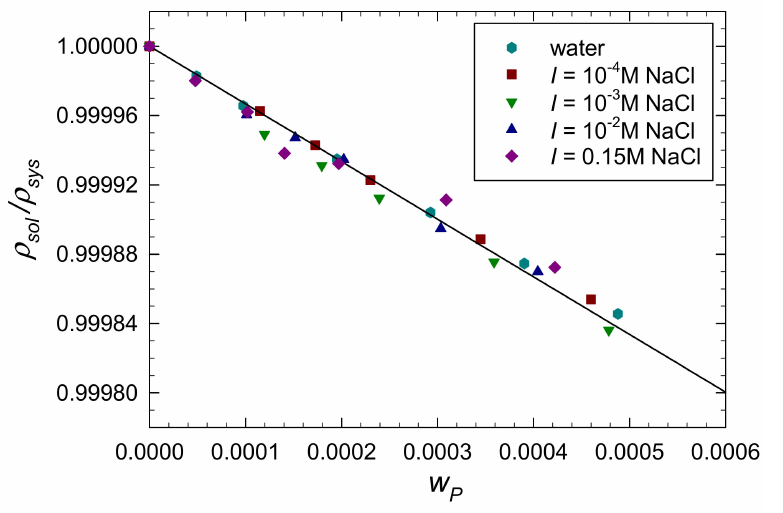
Figure 4. The dependence of the ρ sol / ρ sys on the mass concentration of P-Arg solutions w p for pure water and its solutions of an ionic strength equal to 10 − 4 to 0.15 M at pH 5.7 and T = 298 K. The solid line shows the linear fit of experimental data with the slope s p equal to